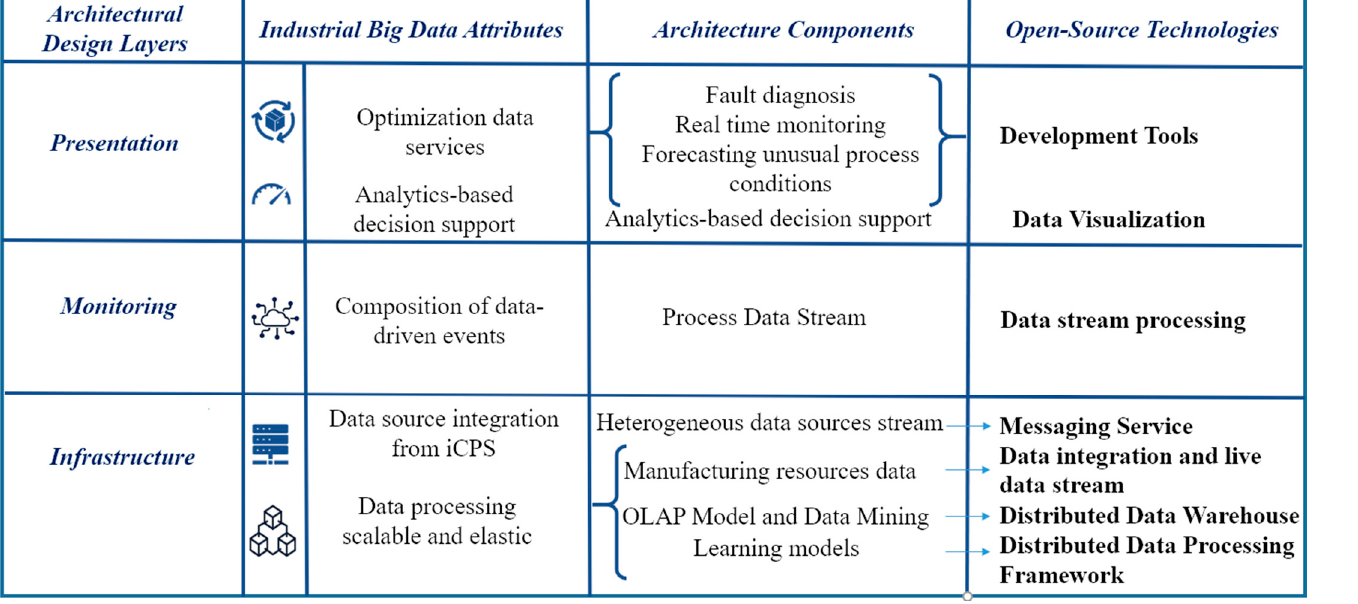
Figure 9. Deployment of component technologies. (Graphics source: image library of Microsoft Office).